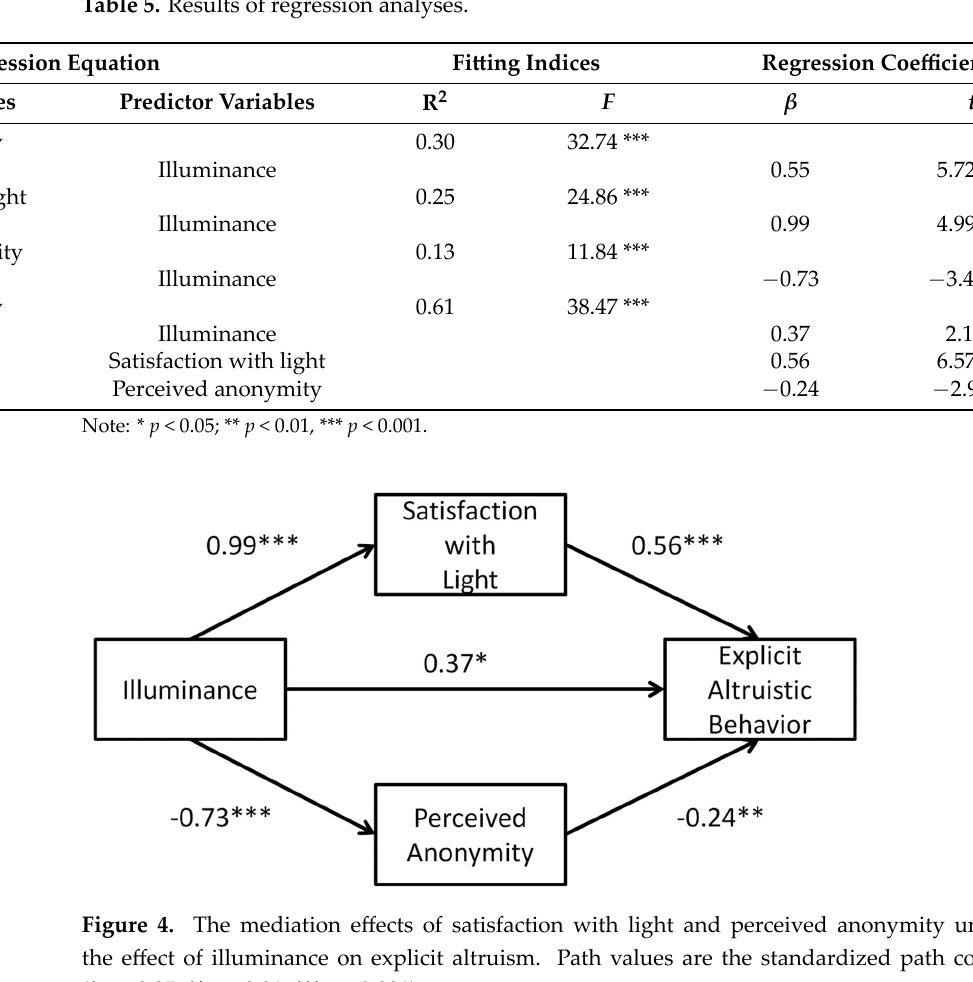
Table 4. Correlations among self-control, perceived anonymity, satisfaction with light and the amount of allocated money in dictator game.